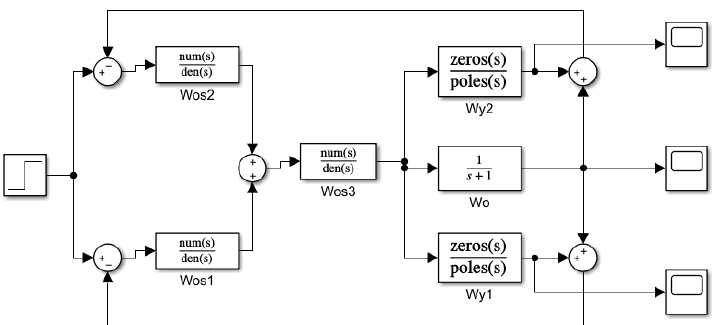
Figure 13. Simulink model of the system with the influence of elastic deformation on the object in Figure 10.